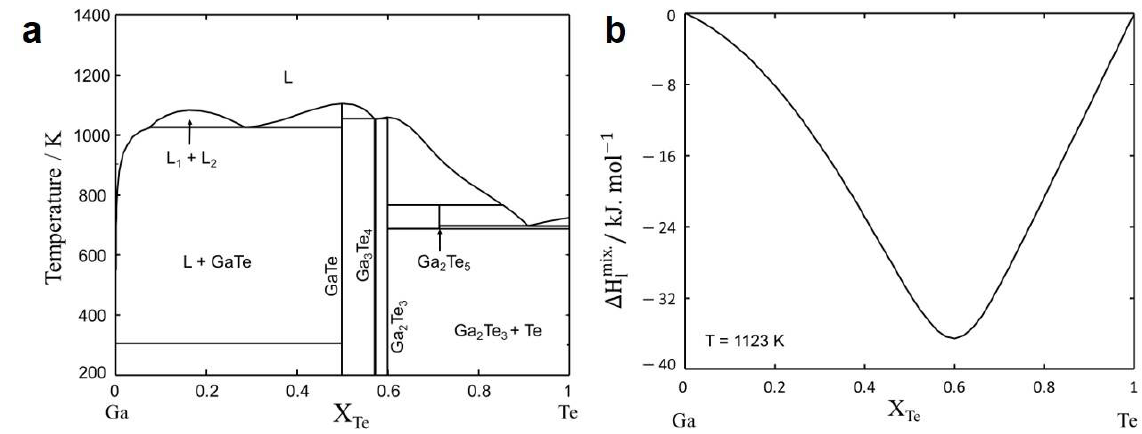
Figure 6. Calculated ( a ) Ga-Te phase diagram and ( b ) integral enthalpy of mixing at 1123 K using thermodynamic description of Kumar et al. [29].